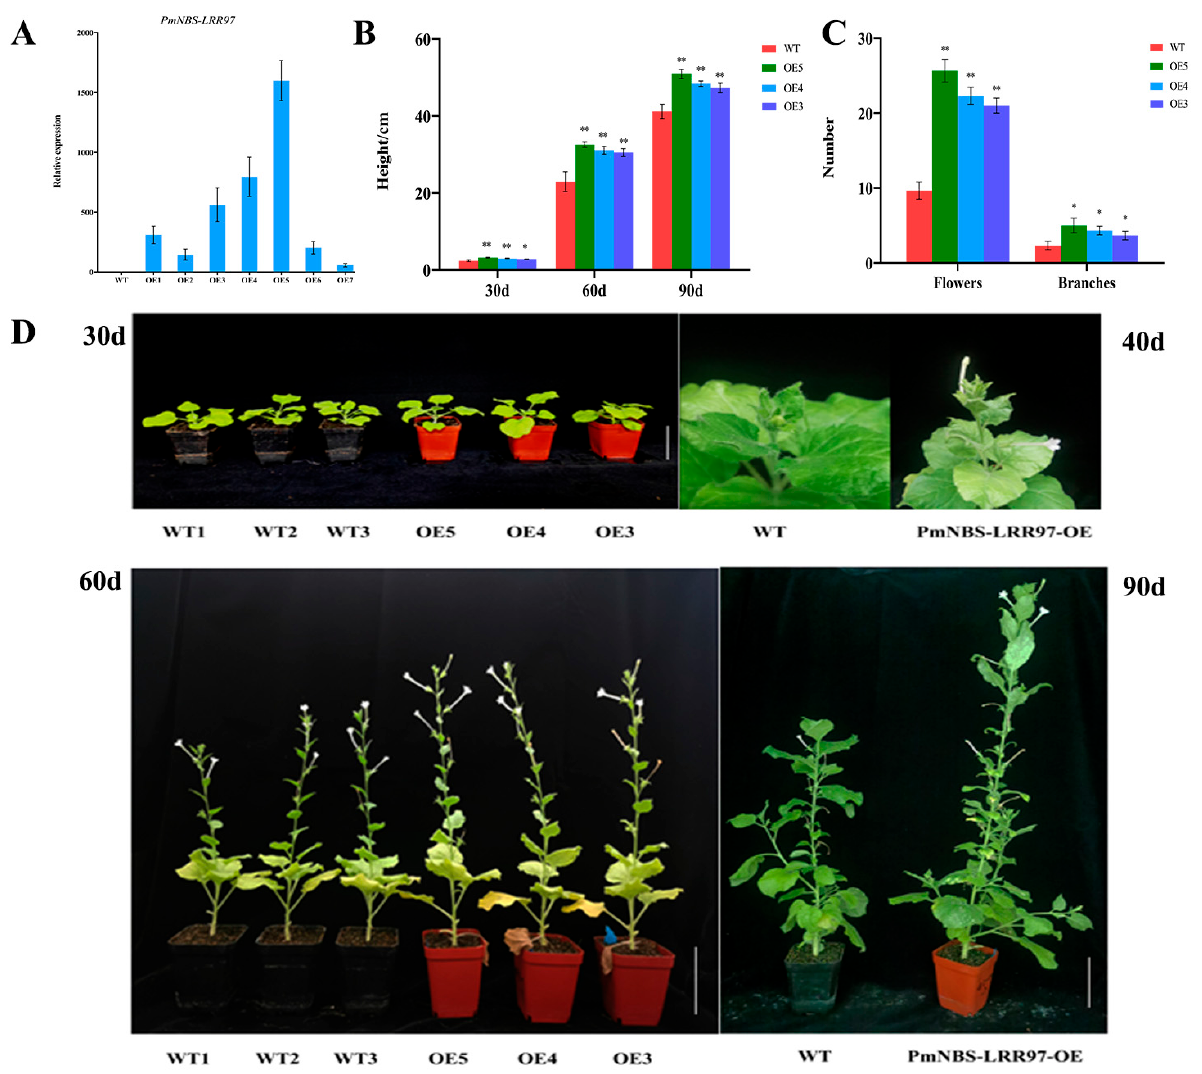
Figure 5. Quantitative verification and phenotypic difference analysis of PmNBS-LRR97 - overexpressing tobacco. ( A ) Relative expression of PmNBS-LRR97 in WT and transgenic tobacco; error bars represent three biological replicates ± SD. ( B ) Plant height analysis of WT and PmNBS-LRR97 - overexpressing tobacco at 30, 60, and 90 d; error bars represent three biological replicates ± SD. Student’s t -test was used to test the significance (*, p < 0.05; **, p < 0.01). ( C ) Differences in the flowering number and branch number between WT and PmNBS-LRR97 -overexpressing tobacco at 90 d; error bars represent three biological replicates ± SD. ( D ) Different phenotypes of WT and PmNBS-LRR97 -overexpressing tobacco. Scale bar = 7cm.